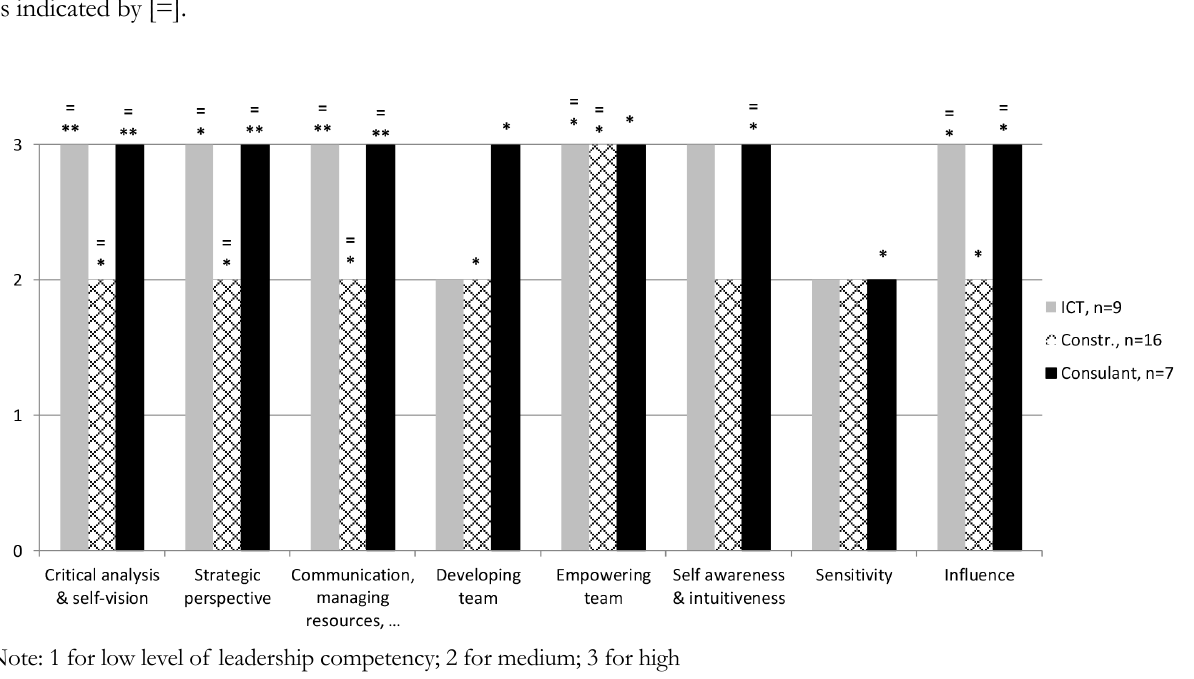
Figure 3. Leadership Profiles across Industry Types for High